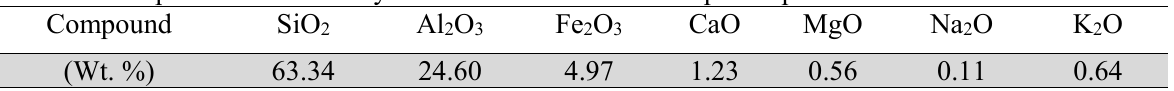
Chemical composition of waste fly ash collected from thermal power plant